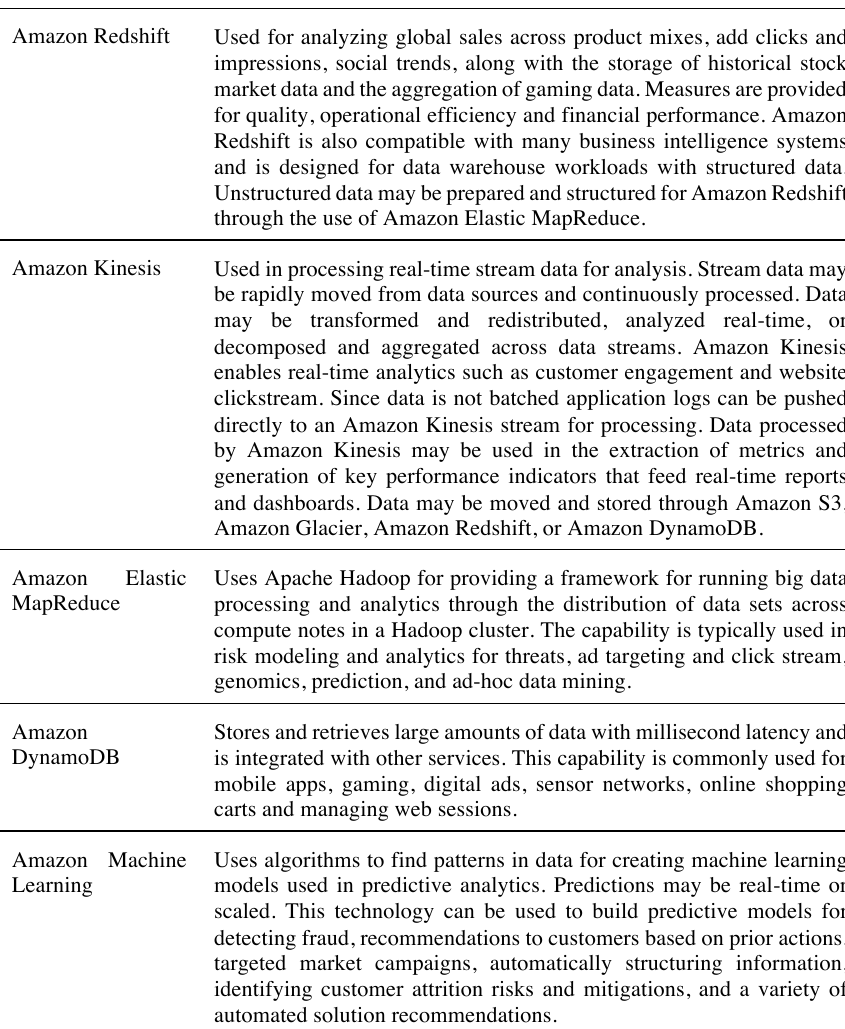
Table 2. Amazon Web Services (AWS) for Big Data Analytics Analytics